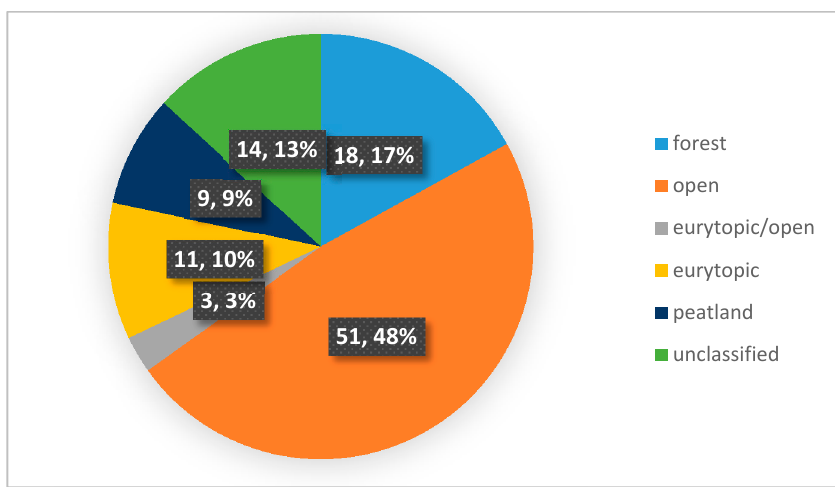
Figure 4. Percentage distribution of Carabidae species found in selected willow and poplar plantations depending on environmental preferences. The diagram was made based on selected publications, including data on the ecological characteristics of Carabidae communities inhabiting investigated plants. Table 2. The number of Carabidae species preferring the forest environment, taking into account the number of species in the classes of eudominants (ED) and dominants (D). The table was made based on selected publications, including data about the ecological characteristic of Carabidae communities inhabiting investigated plants (W1, W2 and unmarked–willow plots; P1–P4–poplar plots). Investigated Plots and Year of